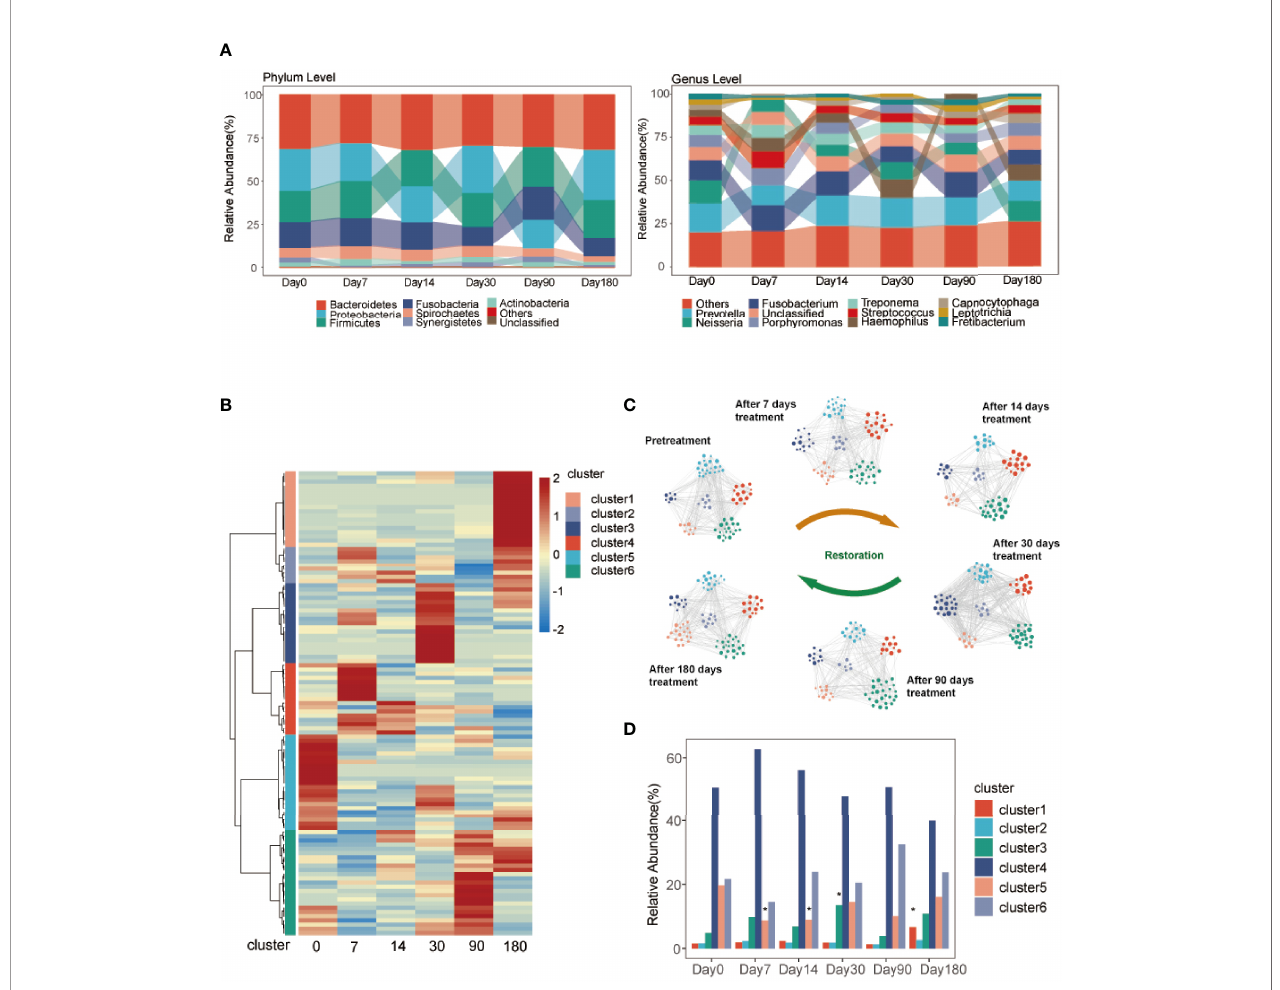
FIGURE 3 | Taxonomies of GCF change over time. (A) Relative abundance of bacterial phyla and genera (top 10) over the six time points. (B) Hierarchical Ward-linkage clustering based on the Pearson correlation coef fi cients of the genera among six time points. The left panel shows hierarchical Ward-linkage clustering based on Pearson correlation coef fi cients of the genera, colored by the co-abundance groups (cluster). (C) The microbiota network of the clusters at the genus level. The size of the node represents the relative abundance of the genus. The color of the node represents the cluster identi fi ed in (B) . The edges are fi ltered with Spearman coef fi cients >0.7, P < 0.05, FDR <10%. (D) The relative abundance of clusters at the six time points. Signi fi cance was measured using the Wilcoxon rank-sum test ( P < 0.05,